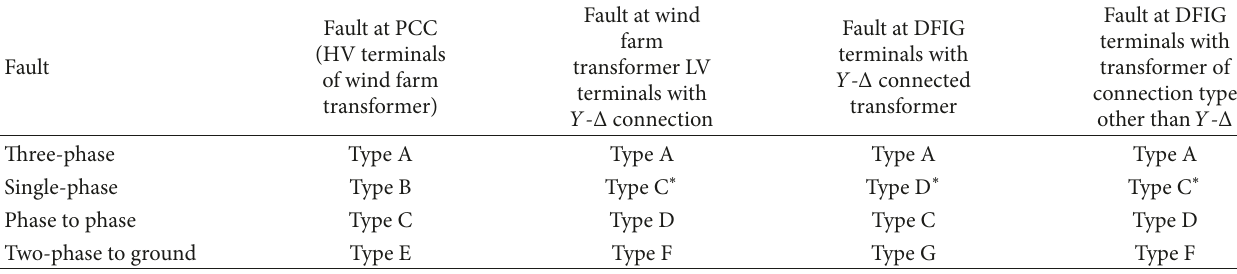
Table 1: Fault propagation inside a wind